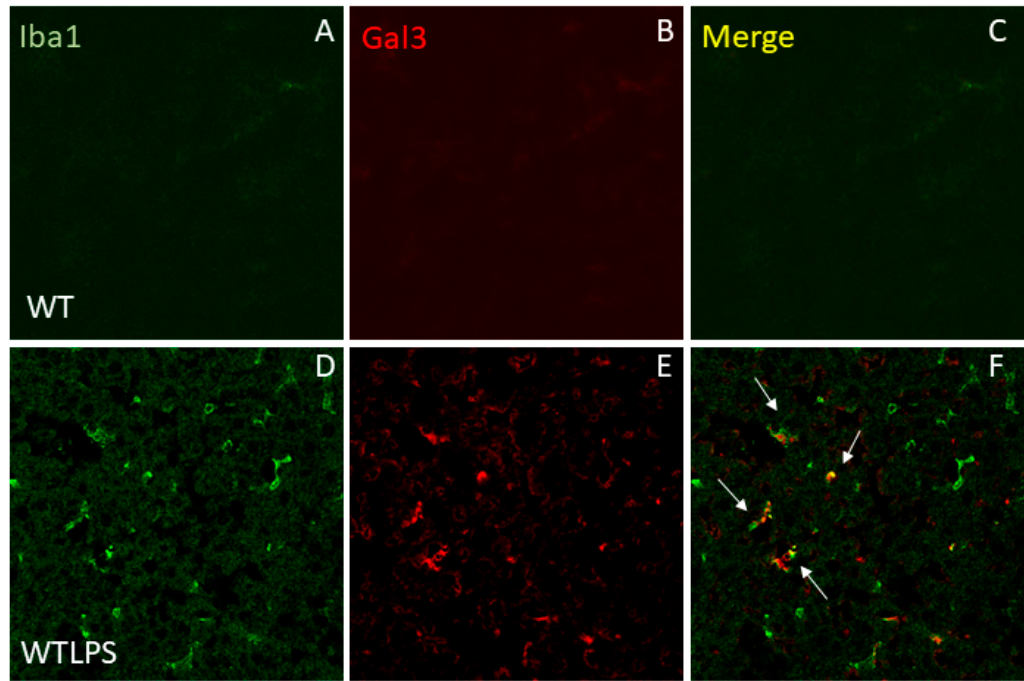
Figure 5. Double immunofluorescence of Iba1 andGal3 expression. ( A ) Iba1 staining in the liver of a WT animal. Virtually, no monocytes/macrophages are infiltrated in control animals. ( B ) Section from liver showing some Gal3 positive cells in a WT animal. ( C ) Merge image showing co-localization of Iba1 + cells and Gal3 + cells. ( D ) Immunoreactivity of Iba1 in a liver section from a WT animal injected i.p. with LPS. A strong reaction can be seen. ( E ) Immunoreactivity of Gal3 in WT animals injected with LPS. ( F ) Merge image showing co-localization of Iba1 + cells and Gal3 + cells (arrows). Most Gal3 + cells co-localize with Iba1 + cells. Scale bar: 50 μ m.